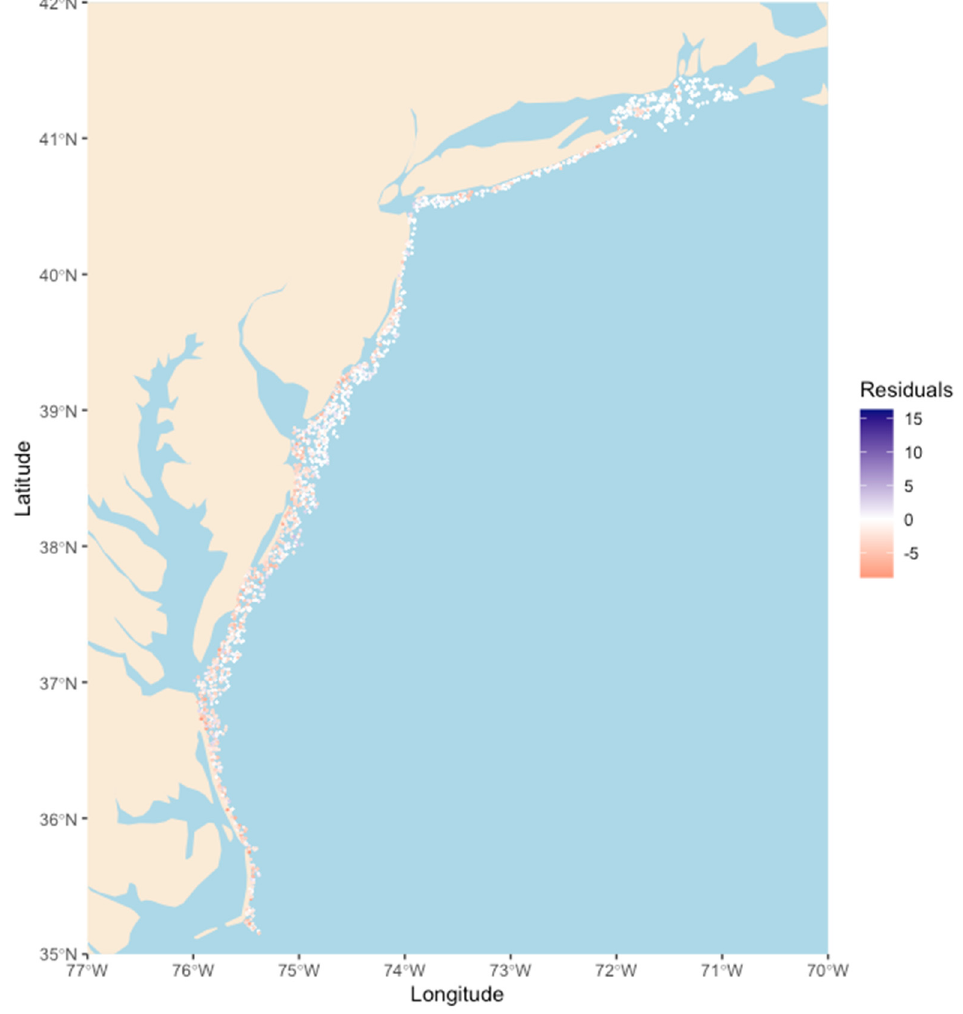
Figure A2. Map of residuals from delta GAM fitted to NEAMAP weakfish survey data. Blue indicates positive, red indicates negative, and color darkness is proportional to the value of residuals.